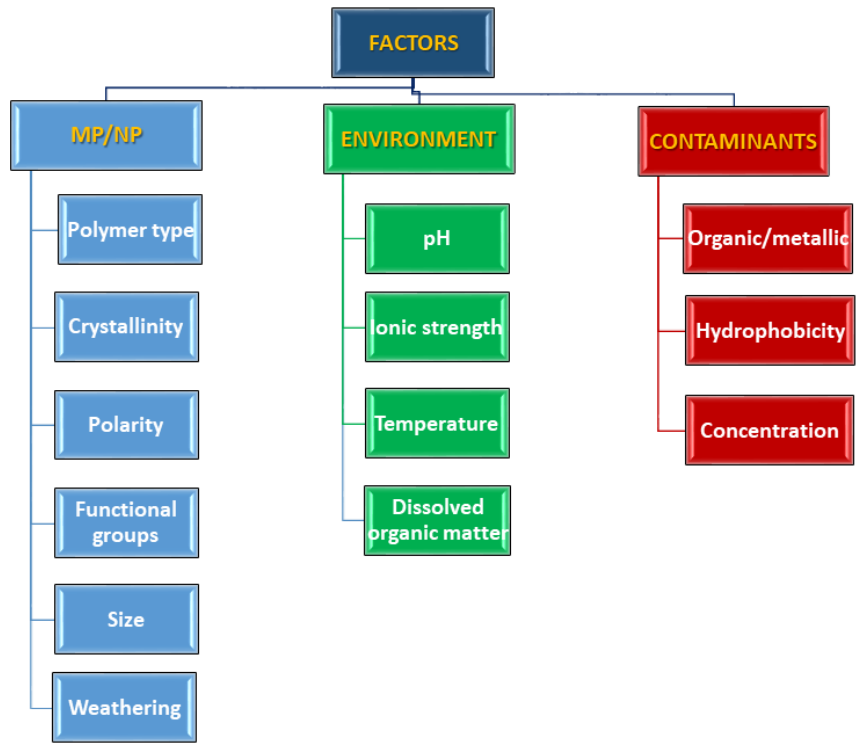
Figure 3. Factors affecting the sorption of contaminants in micro- and nanoplastics (adapted from [151]).